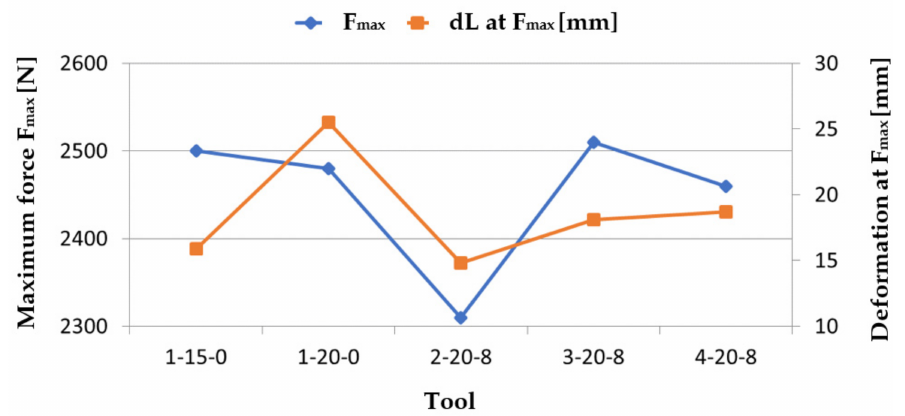
Figure 25. Results of the comparative three-point bending test on material EN AW 7020